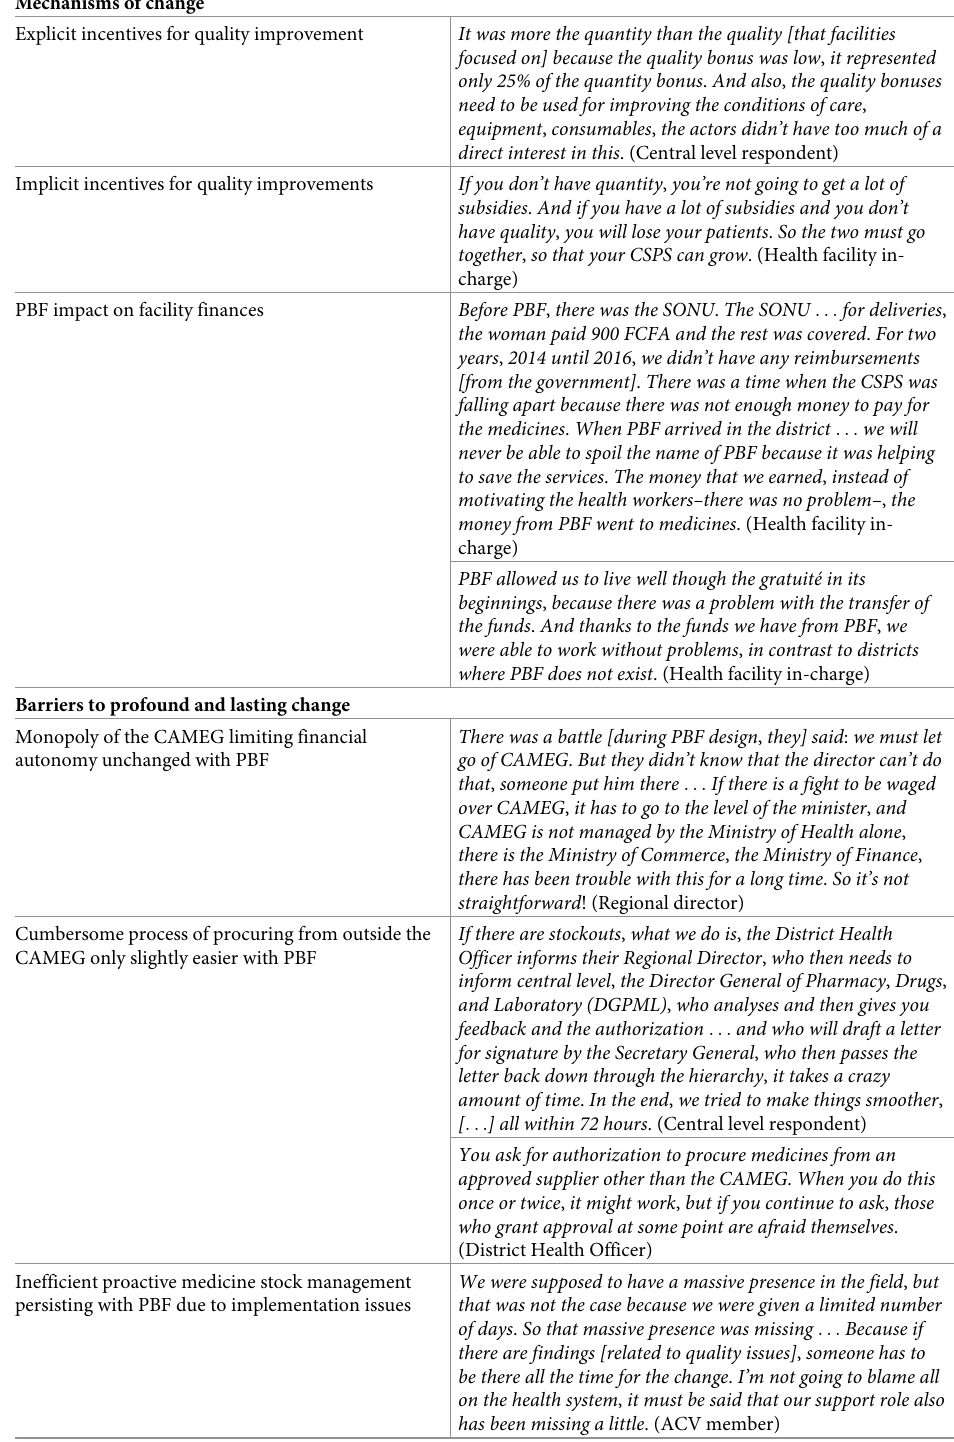
Table 5. Supportive respondent